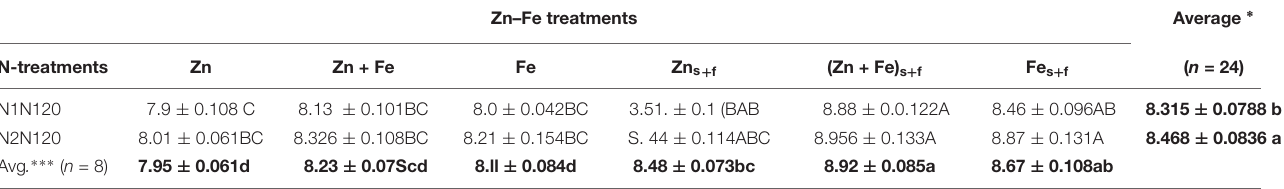
TABLE 4 | Mean ± 1 SE ( n = 4) whole grain protein (%) in wheat grains at experiment with growth media plus foliar application of Zn and Fe. Zn–Fe treatments Average